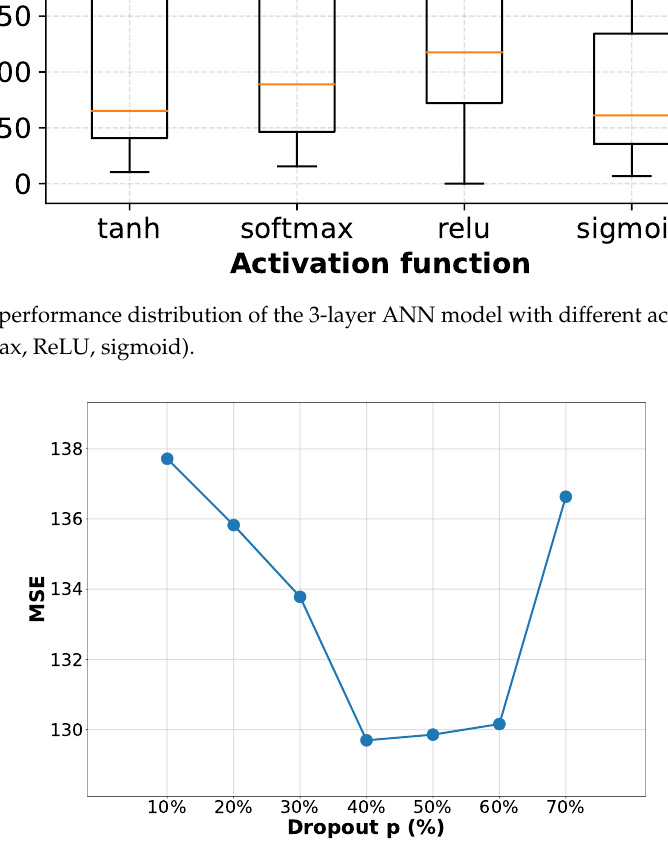
Figure 14. MSE performance of the 3-layer ANN model with different dropout probability values p